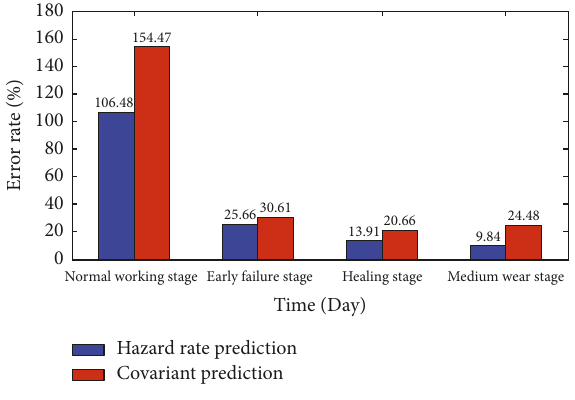
Figure 18: The prediction error of